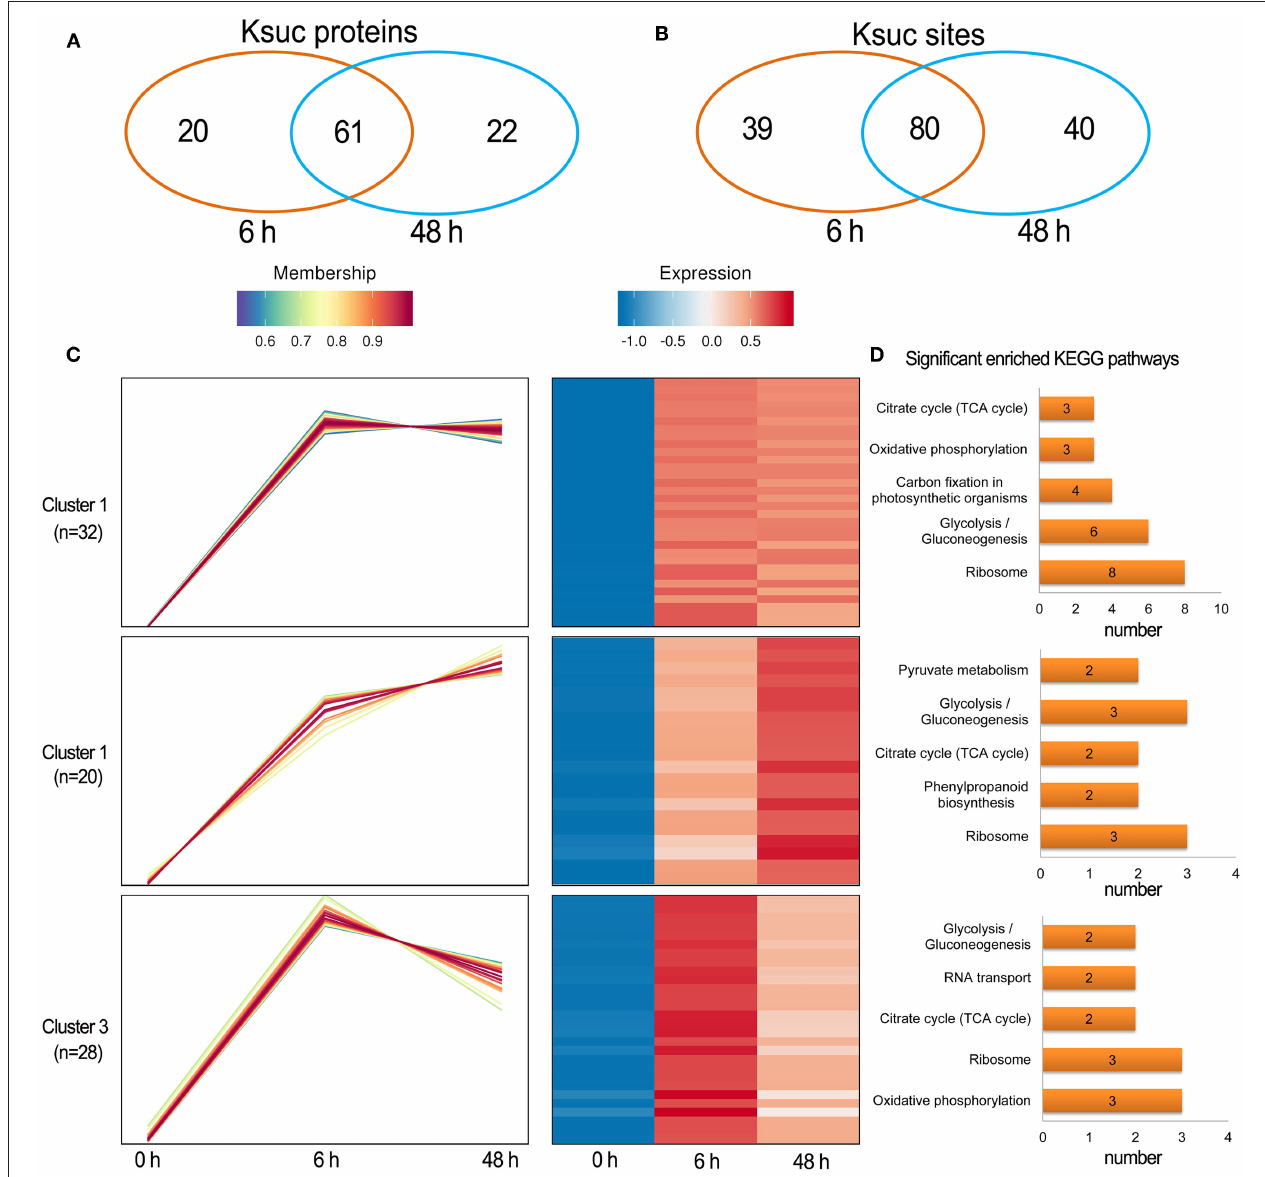
FIGURE 6 | Summary of the differentially succinylated proteins in response to Pi starvation. (A,B) Venn diagram of difffrentially abundant succinylated proteins (sites) in response to Pi starvation; (C) functional clustering analyses (HCL) of the differentially succinylated sites based on the relative succinylation intensity, relative to the control. Cluster identification and number of profiles included in each cluster are indicated on the left. A detailed view of individual profiles is in Supplementary Figure 6 ; (D) KEGG pathway enrichment analysis of DFASPs in each cluster.